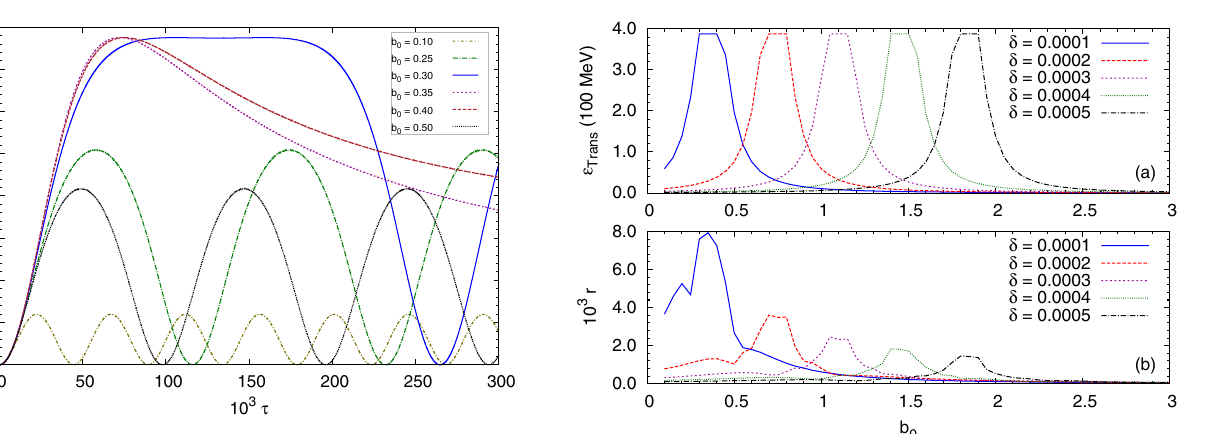
FIG. 9. Maximum energy (a) and radius of the particle orbit in dimensionless units (b) as a function of magnetic field for different values of detuning parameter (cid:5) with phase modulation parameter (cid:3) ¼ 0 : 5 .